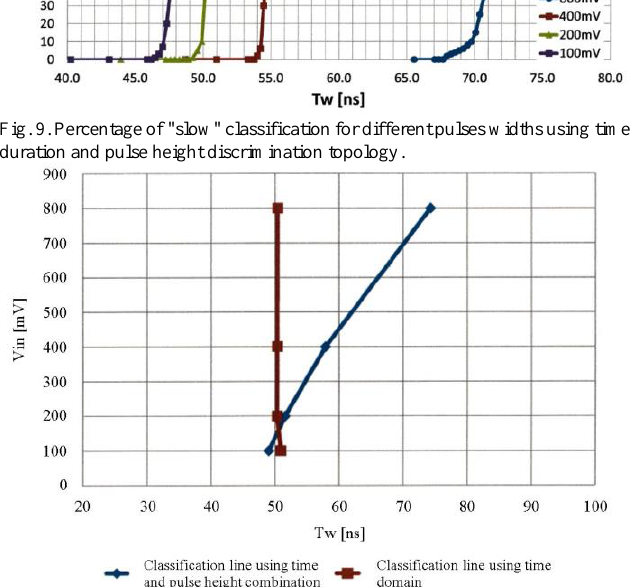
Fig. 10. Measured results of the classification curve in the height – time span, red curve using time duration topology, blue curve using the combined height- time